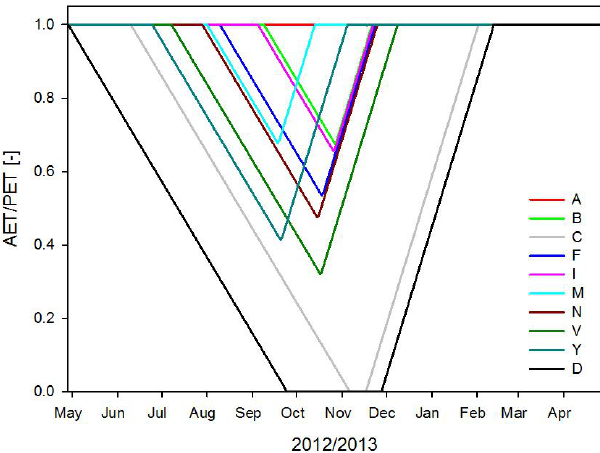
Figure 6: Drying and rewetting phases for the inundation-free period of water body B (GW = 3 Figure 6. Drying and rewetting phases for the inundation-free pe- groundwater) 4 riod of water body B (GW = groundwater).